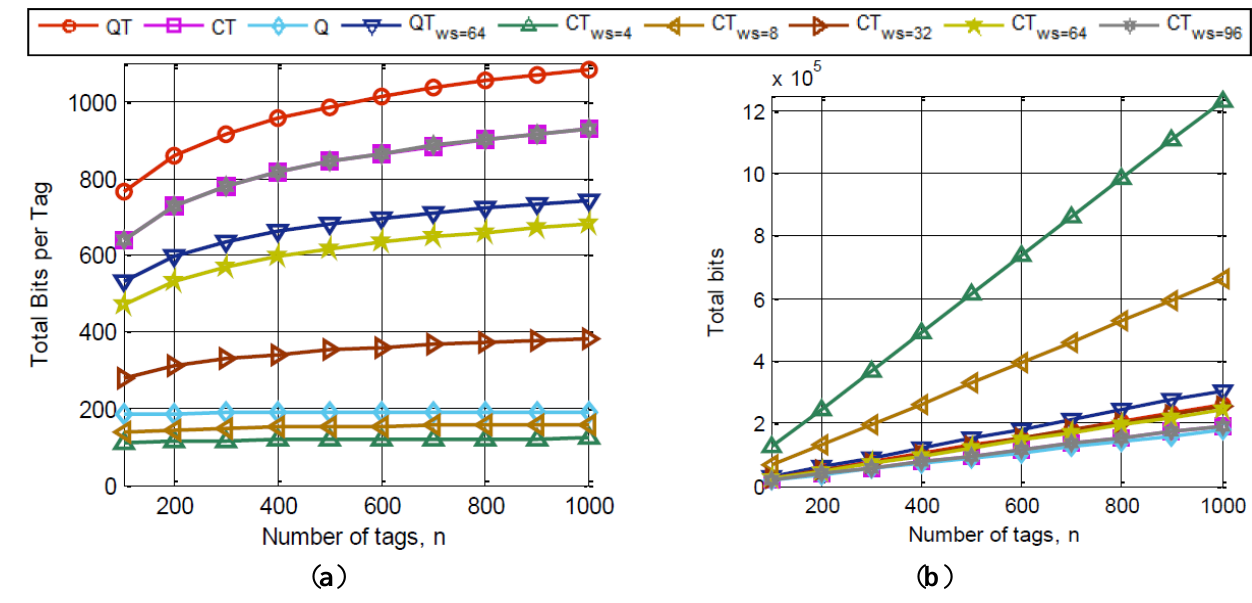
protocol compared to QT, QT ws